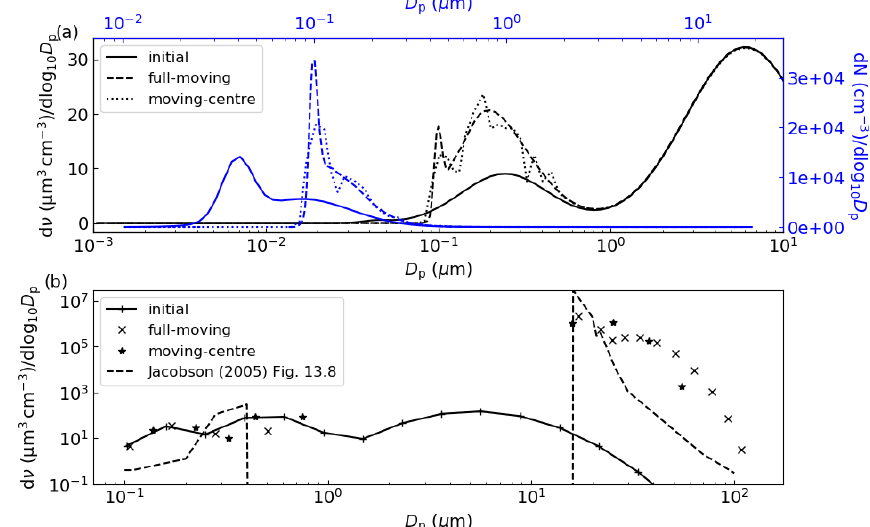
Figure 6. In (a) is a replication of Fig. 3 of Zhang et al. (1999), where constant influx of sulfuric acid condenses to seed particles with the shown initial volume size distribution (bottom and left axis, in black) and initial number size distribution (top and right axis, in blue), with final results after 12h. In (b) is a replication of Fig. 13.8 of Jacobson (2005), where an initial distribution of particles is subject to a relative humidity of 100.002% at minute intervals for 9min, with results shown after